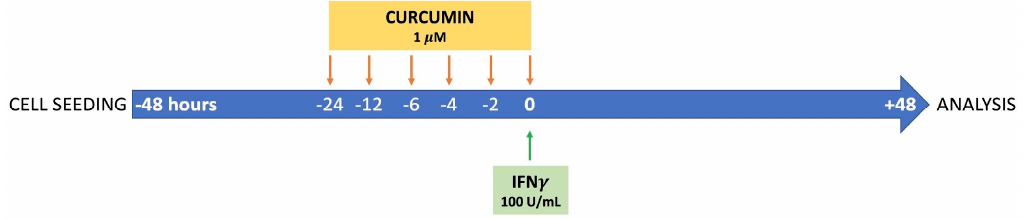
Figure 1. Representative illustration of the experimental design. Forty-eight hours after seeding, HT29 cells were stimulated with 100 U/mL IFN γ as inflammatory stimulus. To investigate the protective effect of curcumin, cells were pre-incubated with 1 µM curcumin (derived from Curcuma Longa ) at different time points: 24, 12, 6, 4, 2, or 0 h before the IFN γ treatment. At 96 h of culture (48 h after the addition of IFN γ ) cells were harvested for analysis.